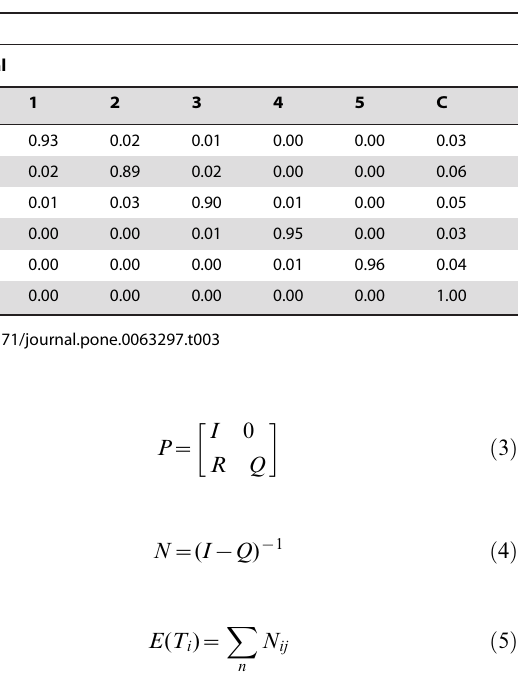
Table 3. Daily transition probabilities between incident complexity levels, presented at the national